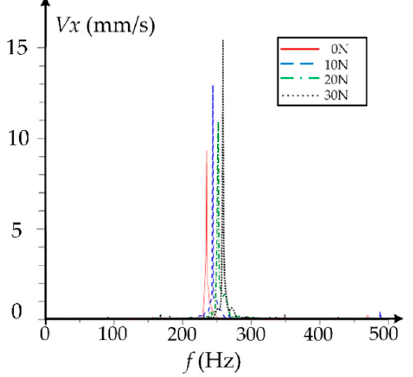
Figure 14. The bearing vibration under different axial loads when L = 1.7.